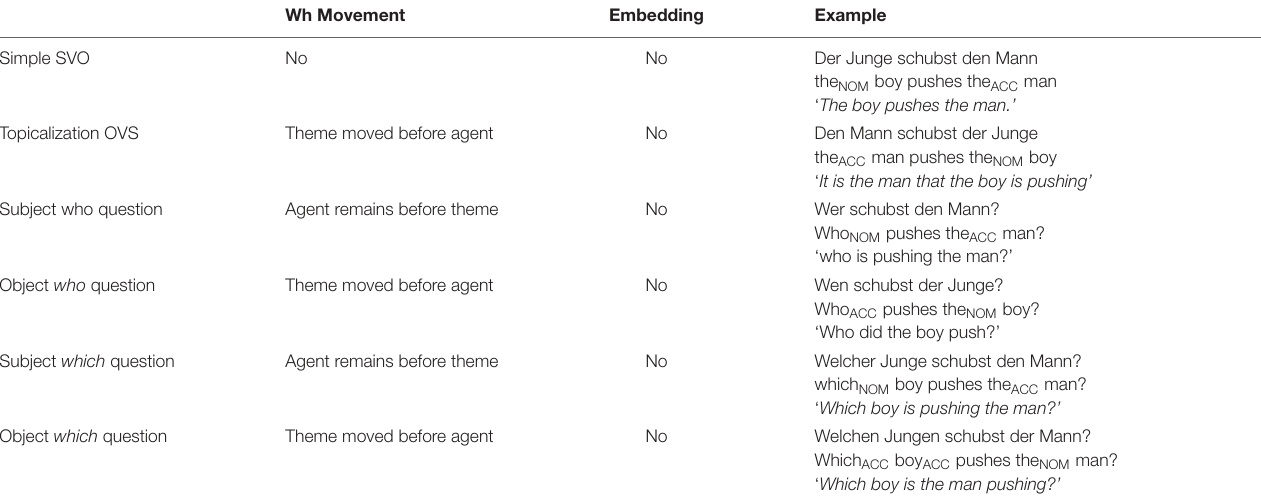
TABLE 2 | Types of sentences in Experiment 2. Wh Movement